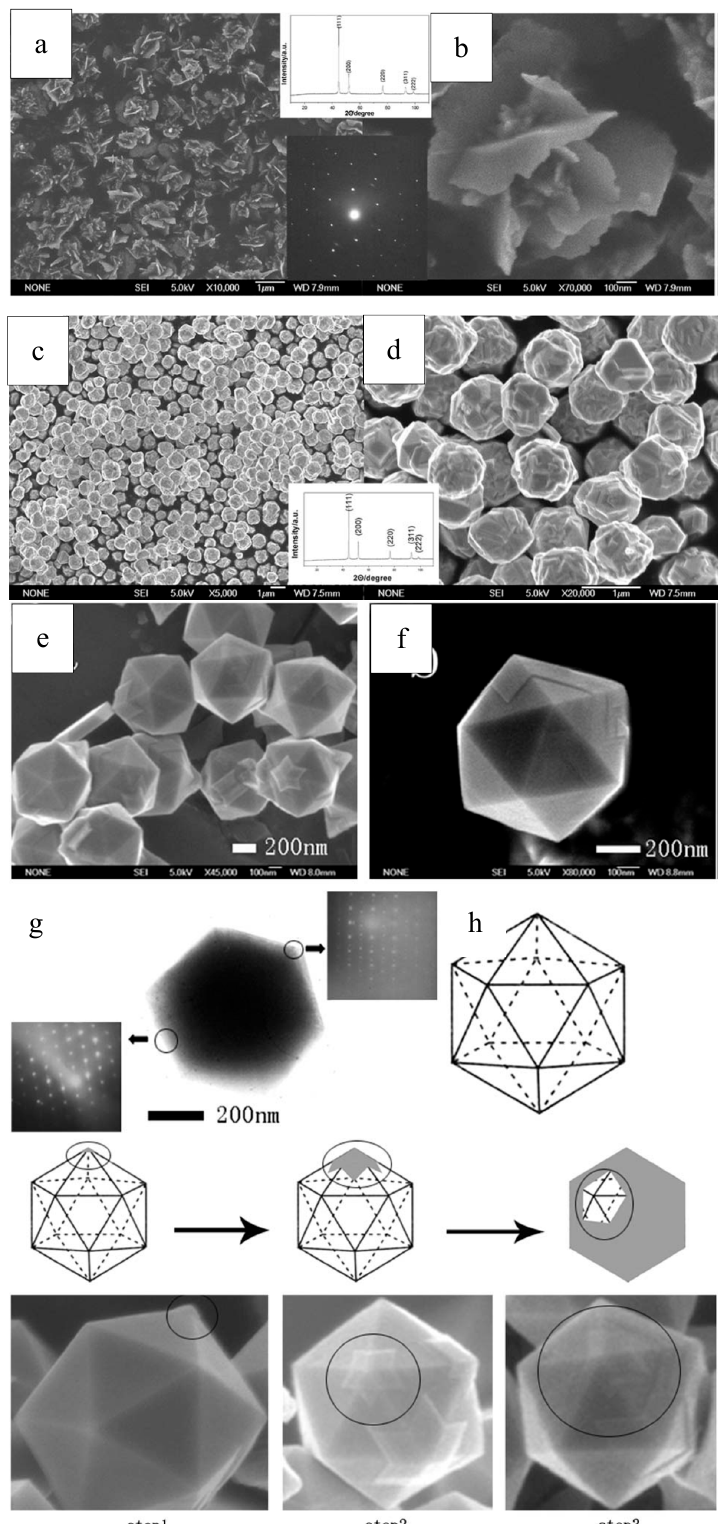
Figure 9. SEM of Ni particles from our work ( a - b . Ni obtained using hydrazine hydrate as reducing reagent, with no surfactant introduced; ( c ). Ni obtained when excessive NaOH (NaOH/Ni = 2.5) was used; ( d ). Ni obtained when the molar ratio of N 2 H 4 /Ni was raised to 6 and no NaOH was added; e. Ni obtained when ethylene glycol was used; f. Ni obtained when ethanol was used). Reproduced with permission [164]. Copyright 2012, Springer.